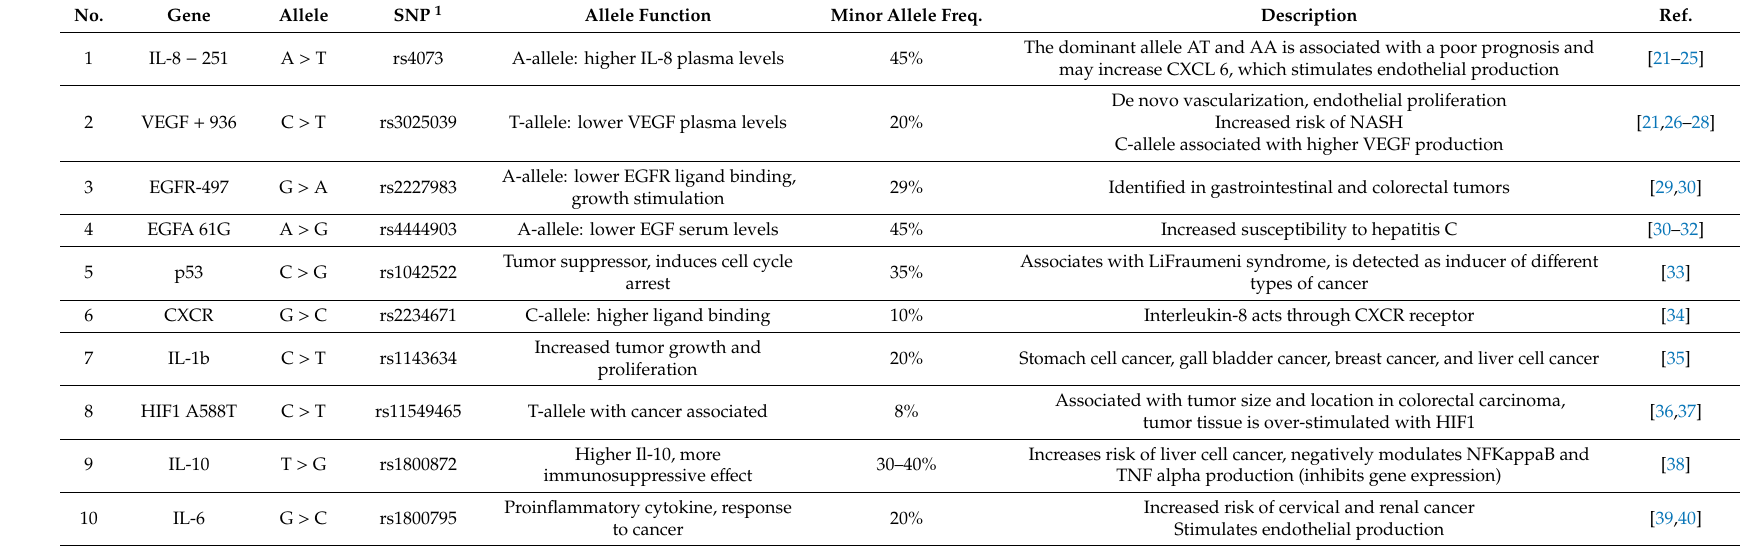
Table 1. Genes, their function, and the minor allele